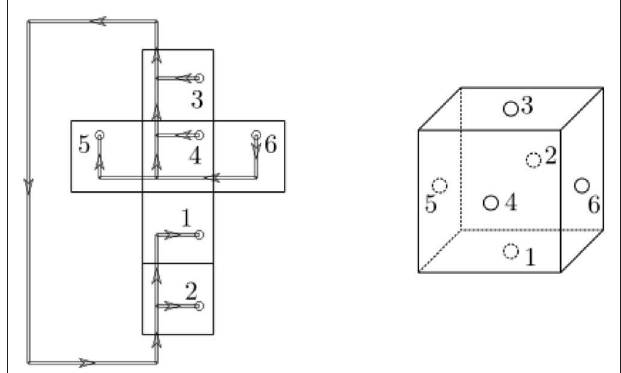
FIGURE 13 | An example of a fusion tree for a 3D cube with six punctures. The tree is drawn on the boundary of the 3D cube, here “unfolded.” The order of the fusion of punctures determines which set Ribbon operators is diagonalized.